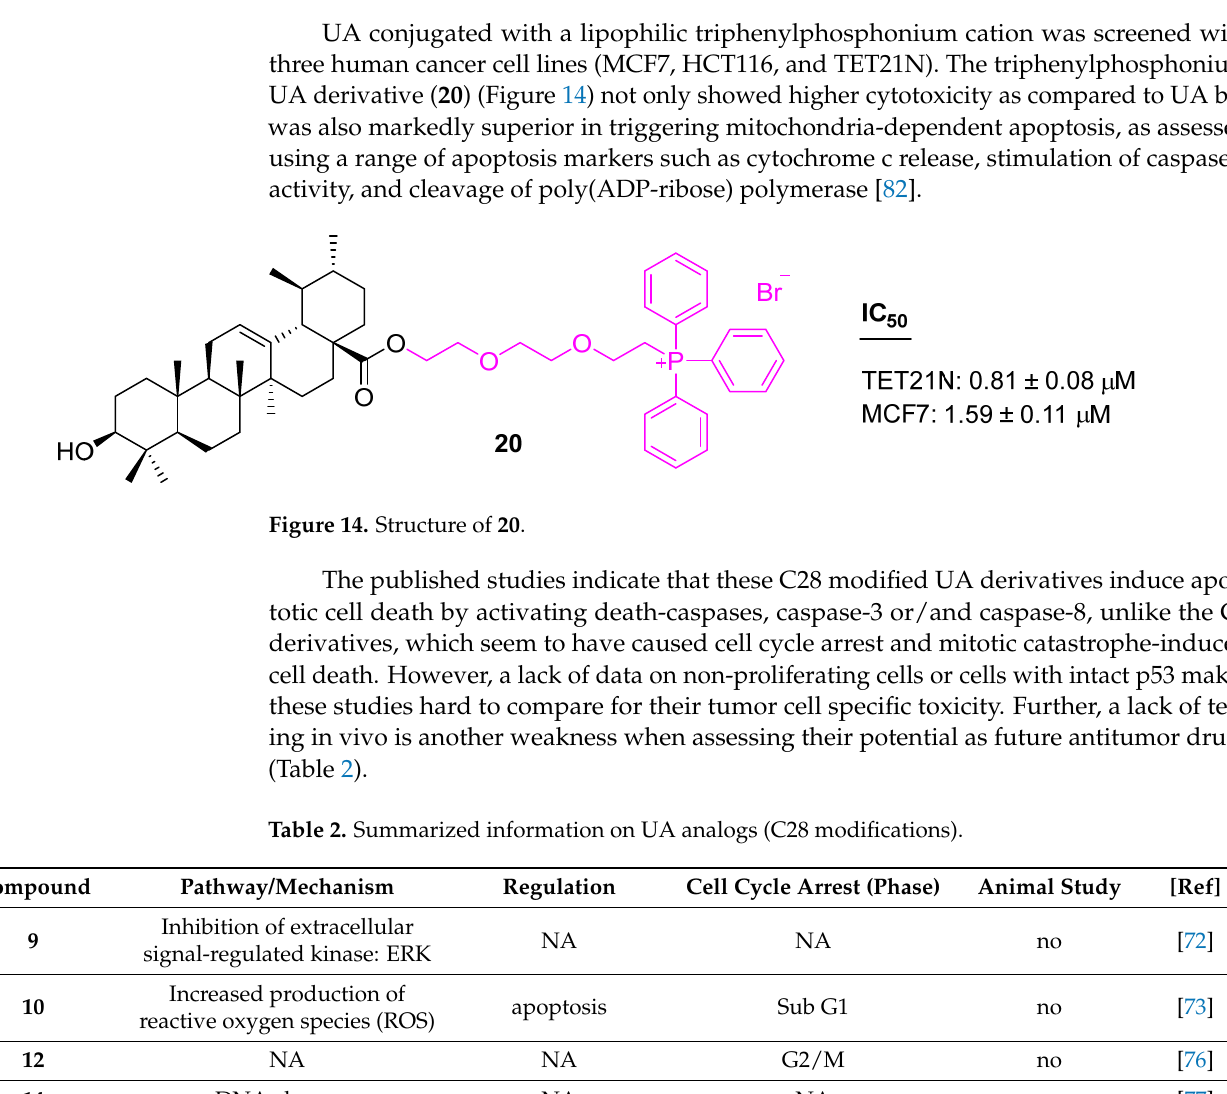
Figure 13. Structure of 18 , 19 .